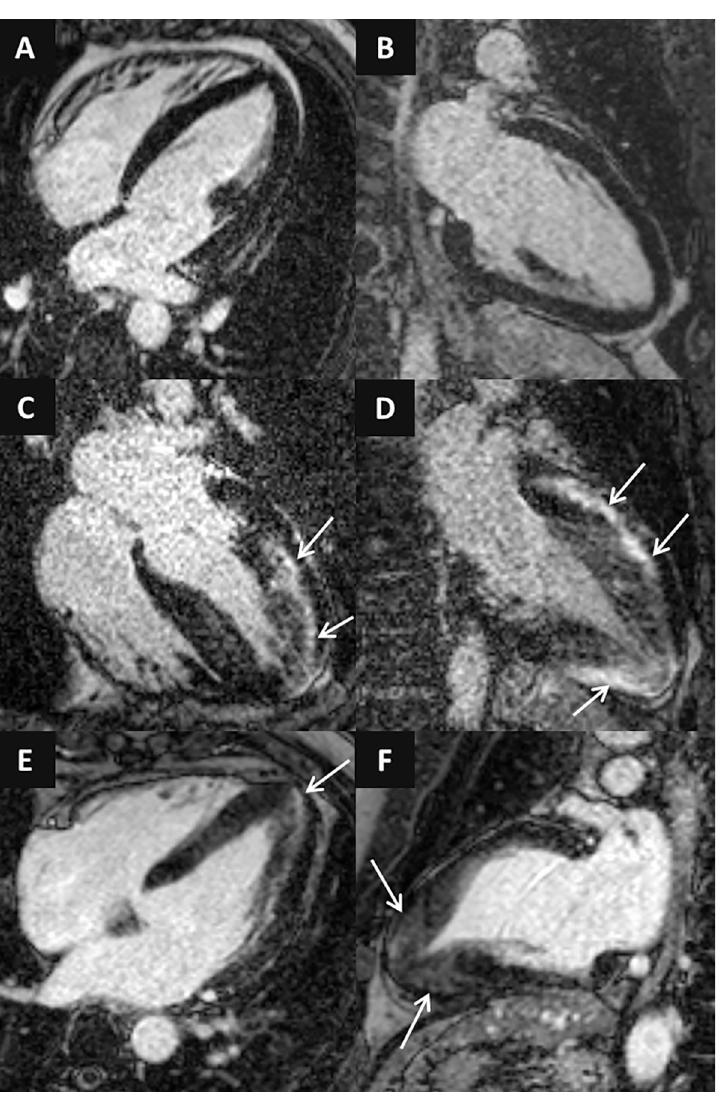
Fig 3. LGE images in 4-chamber (A,C,E) and 2-chamber views (B,D,F) of athletes with HCM. Concentric HCM with no LGE (A,B), asymmetric form with pronounced midmyocardial patchy LGE (C,D) and apical HCM with mild LGE in the hypertrophic segments